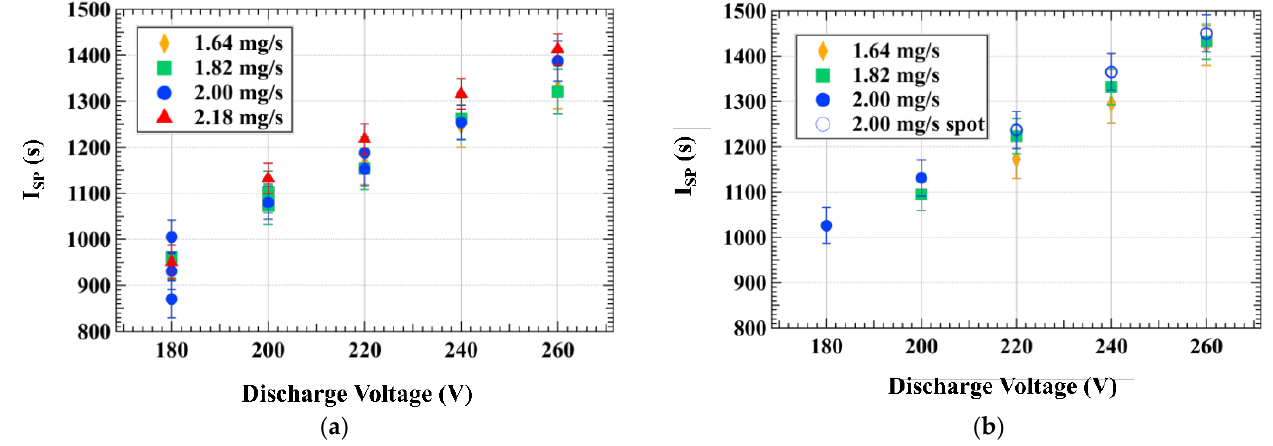
Figure 7. ( a ) Anode specific impulse as a function of discharge voltage and anode mass flow rate for 5-s tests; ( b ) Anode specific impulse for 15-s tests.